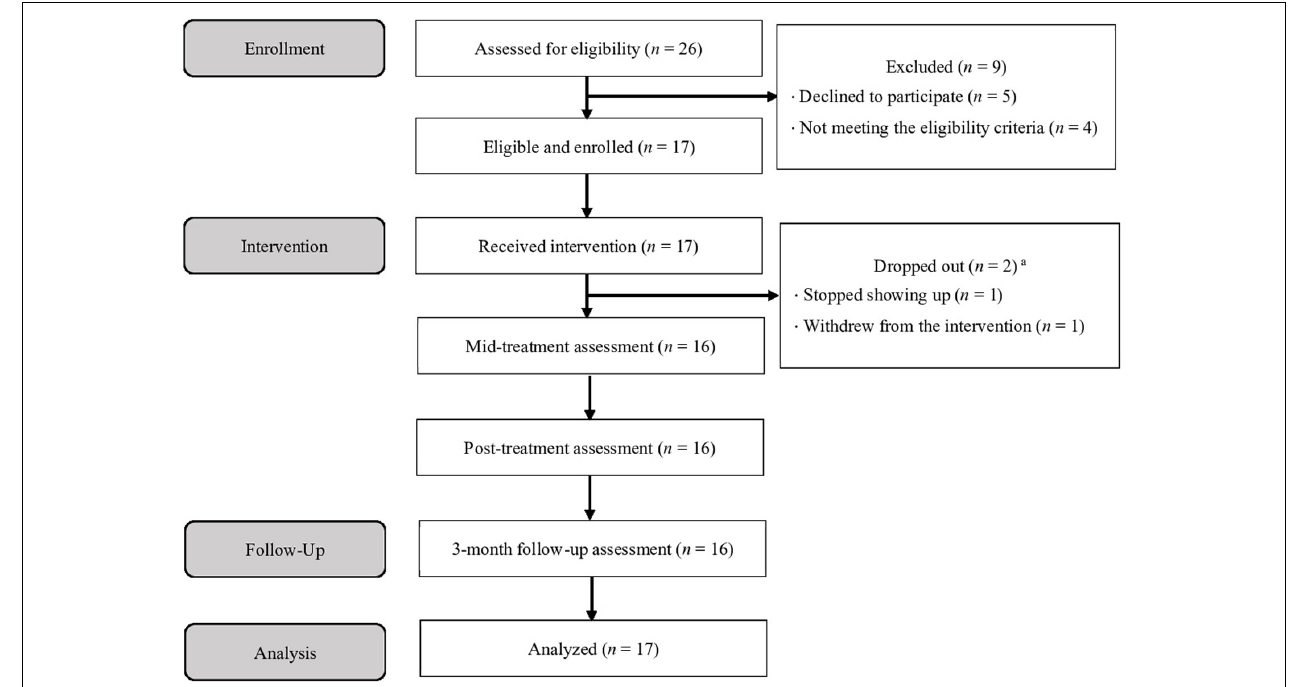
FIGURE 1 | Participant flow diagram. a One patient withdrew from the intervention but completed all